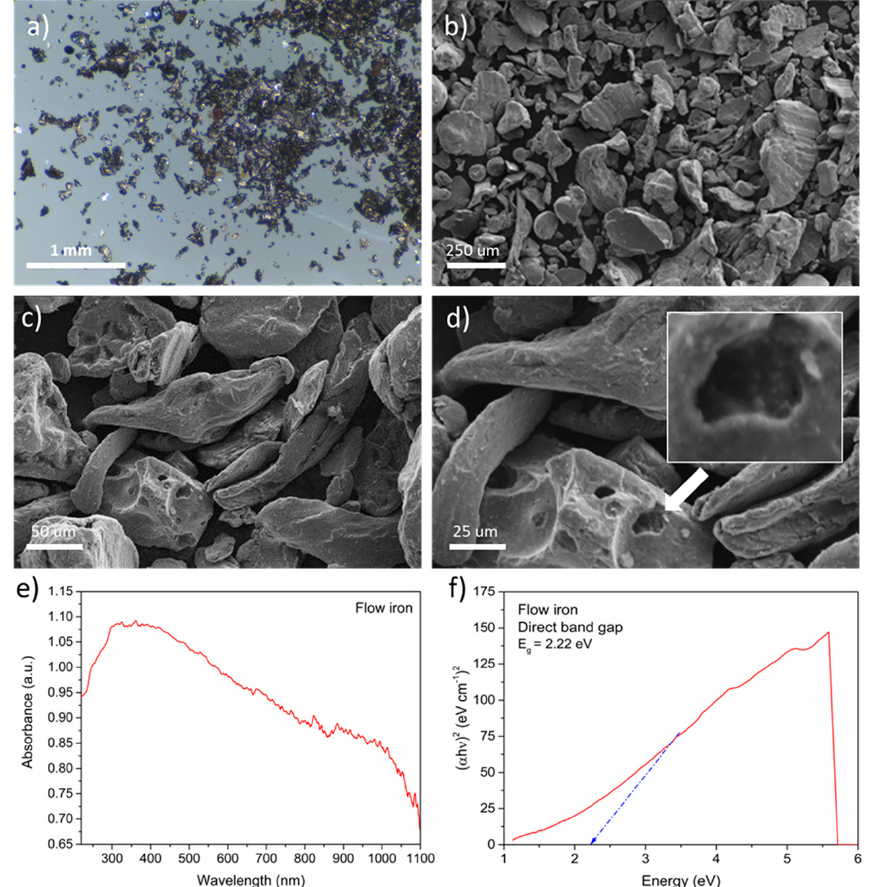
Figure 1. ZVI characterization: ( a ) digital images, ( b – d ) SEM images, ( e ) absorbance, and ( f ) direct band gap.